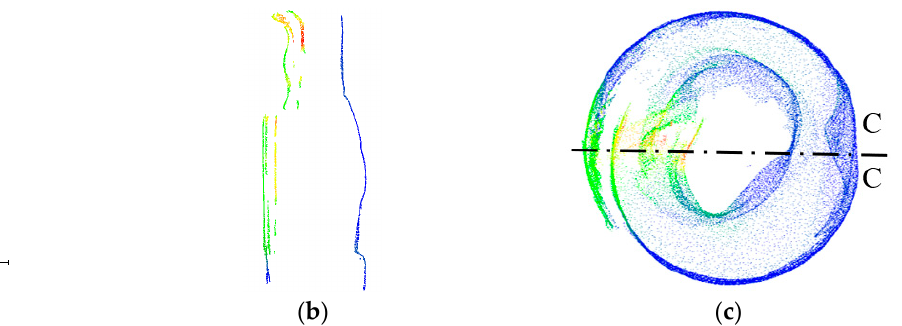
Figure 11. Sections of the point clouds of the statue scanned at distance of 3 m; the scalar field refers to the surface variation value: section of stem of statue ( a ), vertical section C-C of the statue in the scan closure zone ( b ), top view of the statue and indication of the vertical section C-C ( c ). Table 4. Surface variation and omnivariance values of the statue, second case study. Object Scanned Scan Distance: 2 m